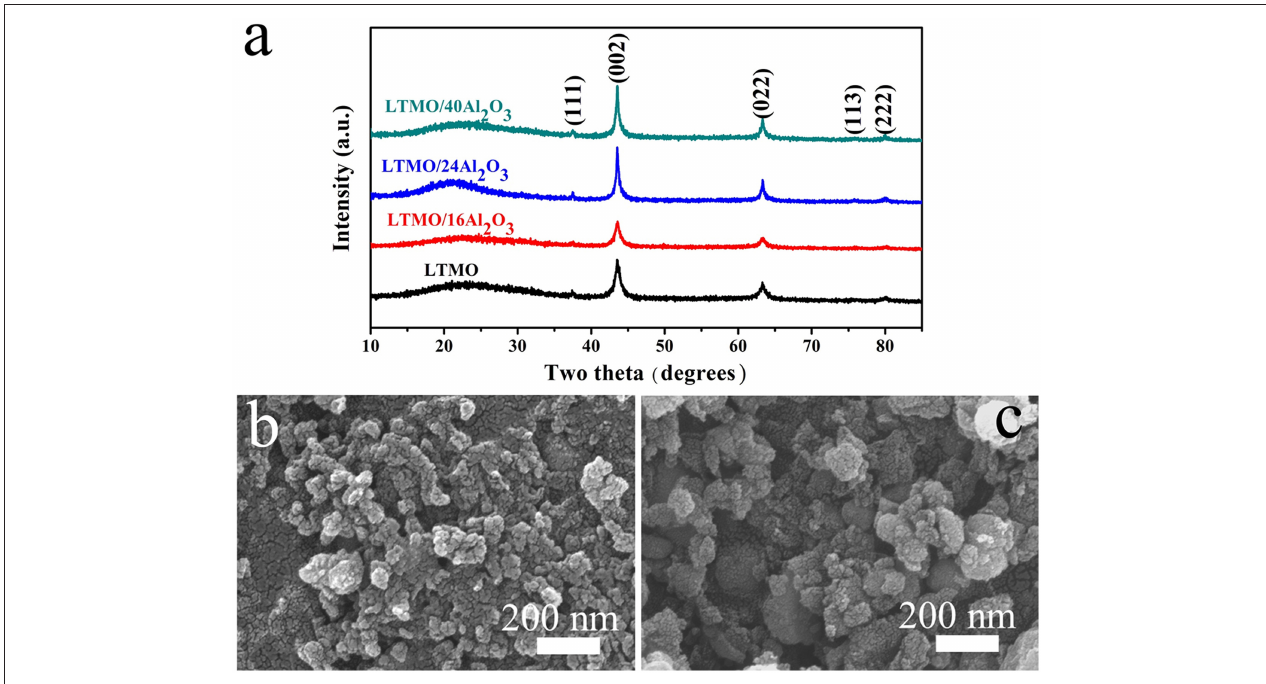
FIGURE 1 | (a) XRD pattern of the bare LTMO and different Al 2 O 3 -coated LTMO; SEM image of (b) LTMO and (c) LTMO/24Al 2 O 3